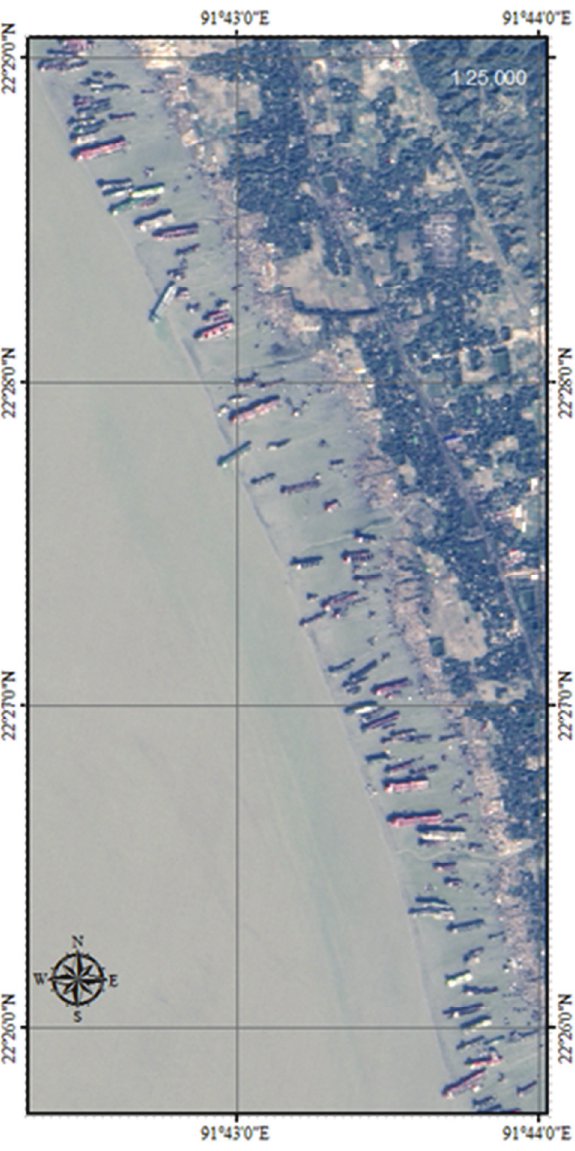
Figure 5. ALOS pan-sharpen (PRISM/AVNIR-2)